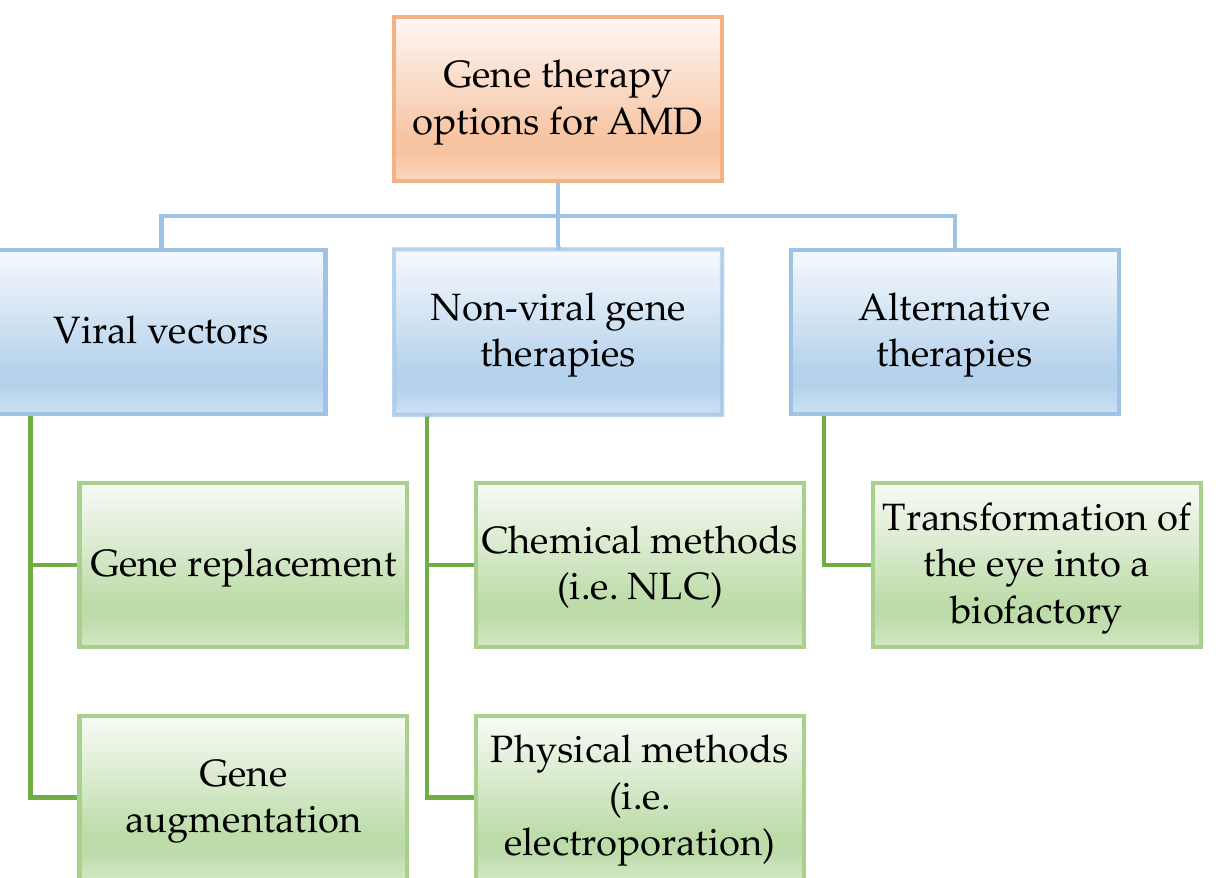
Figure 2. Schematic representation of the gene therapy options available in the literature showing their modus operandi .